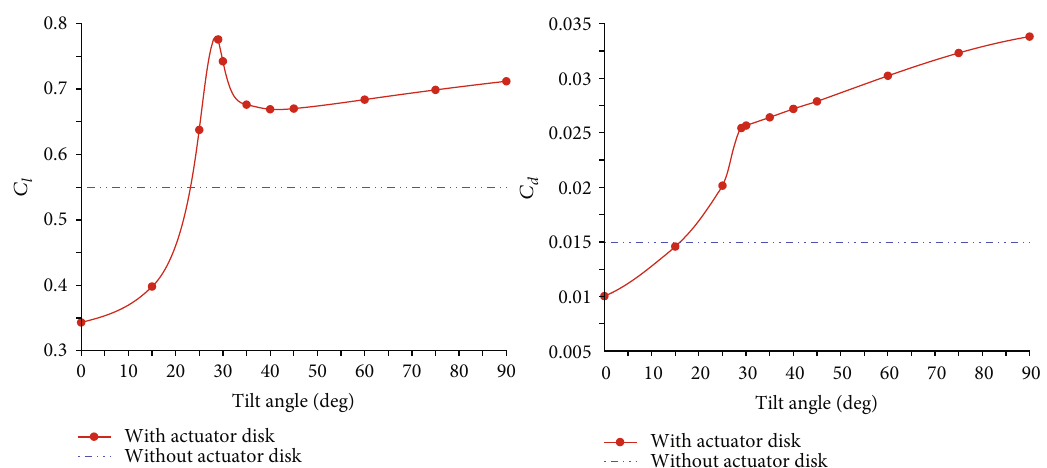
Figure 19: Quasi-steady lift and drag coe ffi cients at fi xed tilt angles.